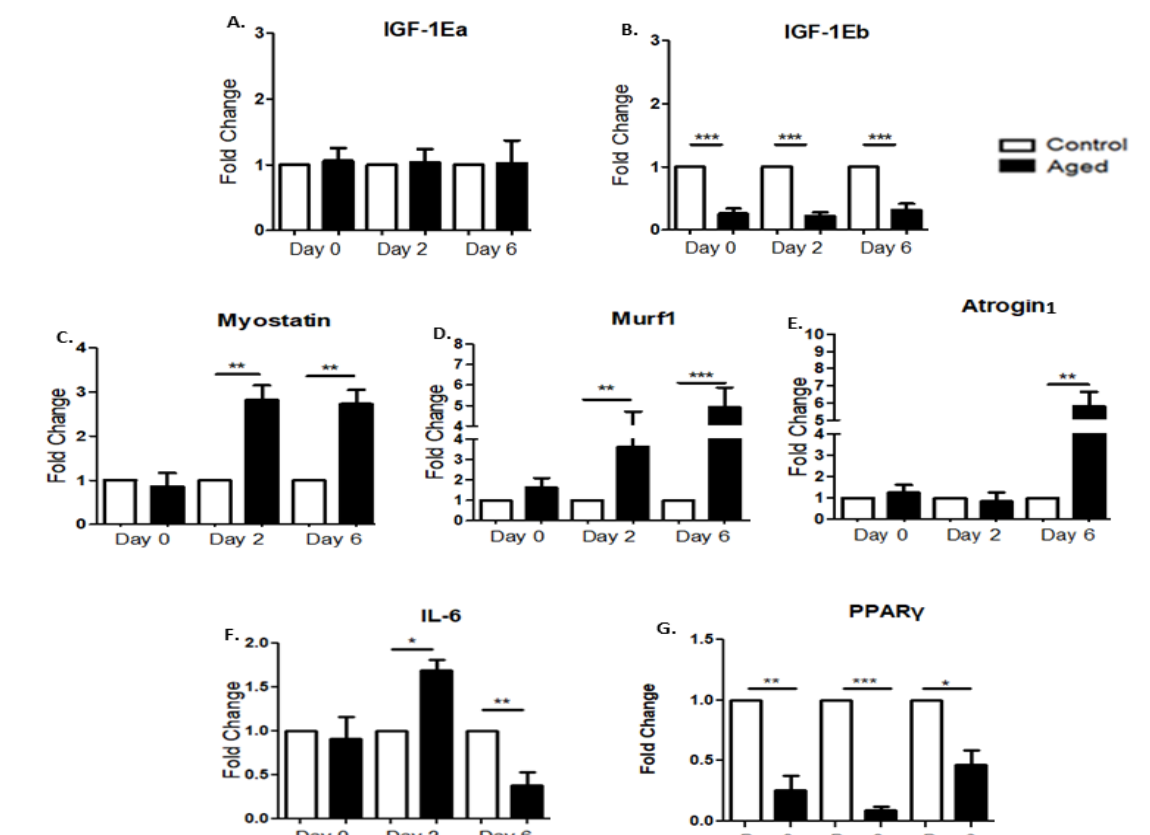
Figure 3. ( A , B )Effects of myoblast aging on the expression of IGF-1 isoforms. Quantitative analysis of IGF-1Ea ( A ) and IGF-1Eb ( B ) mRNA expression in aged myoblasts compared to controls during their differentiation. ( C – E ) Effects of myoblast aging on the expression of muscle atrophy genes during myoblast differentiation. Quantitative analysis of myostatin ( C ), Murf1 ( D ) and Atrogin1 ( E ) mRNA expression in senescent myoblasts compared to control cells during their myogenic differentiation. ( F , G ) Effects of myoblast aging on the expression of inflammatory and metabolic factors. Quantitative analysis of IL-6 ( F ) and PPAR- γ ( G ) mRNA expression in senescent myoblasts compared to control cells during their differentiation. The mRNA values of the factors of interest in aged myoblasts have been normalized to the corresponding GAPDH mRNA and are expressed as fold changes compared to control myoblasts. (Mean ± SE of 3 independent experiments performed in triplicate; * p < 0.05, ** p < 0.01, *** p <